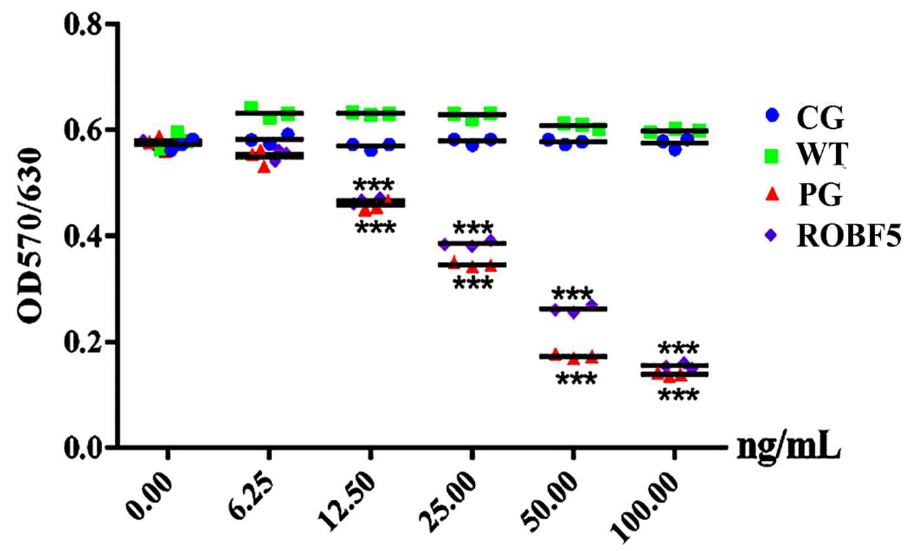
Figure 2. Effects of recombinant oil body on the inhibition of hair follicle epithelial proliferation (*** p < 0.001). CG: Control group (PBS), WT: wide-type oil body, PG: positive group (hFGF5), ROBF5: recombinant oil body expressing hFGF5 .